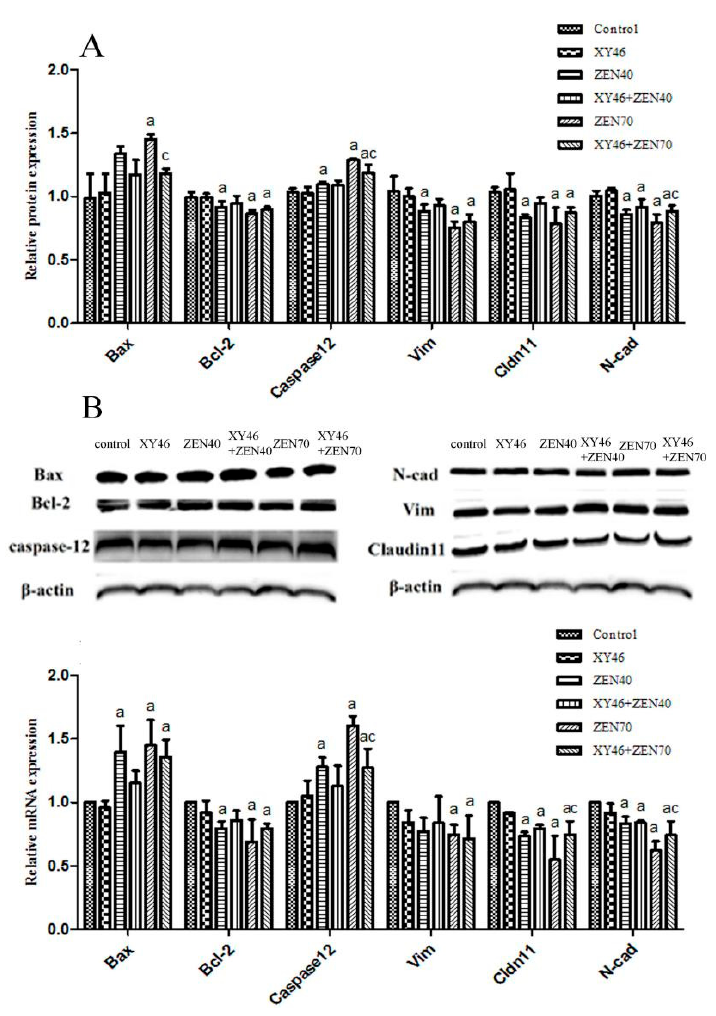
Figure 8. The results for mRNA and protein expression in mouse testes, showing: ( A ) protein expression levels, ( B ) mRNA expression levels. Key: ‘a’—significantly di ff erent compared to the control group ( p < 0.05), ‘b’—significantly di ff erent xy46 + ZEA40 result to the ZEA40 result ( p < 0.05),